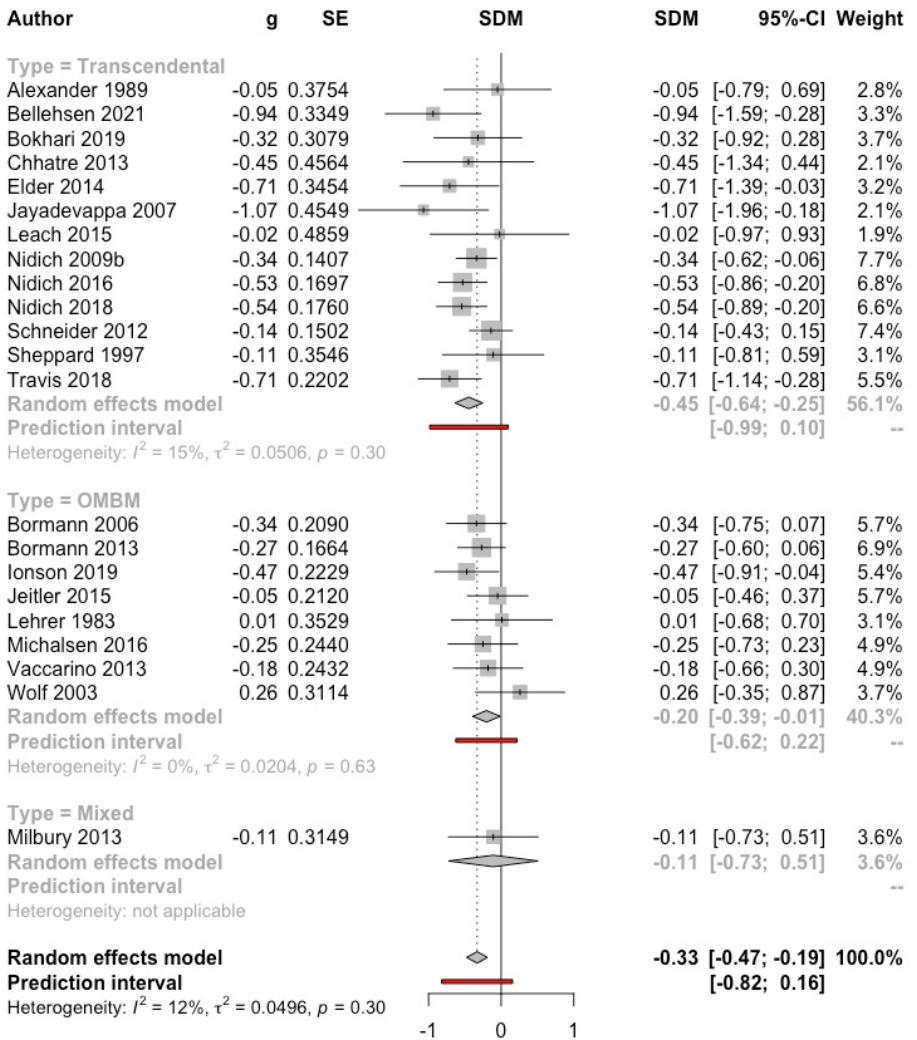
Figure 4. Effect on depression (meditation vs. control). Predictive intervals are represented in red.